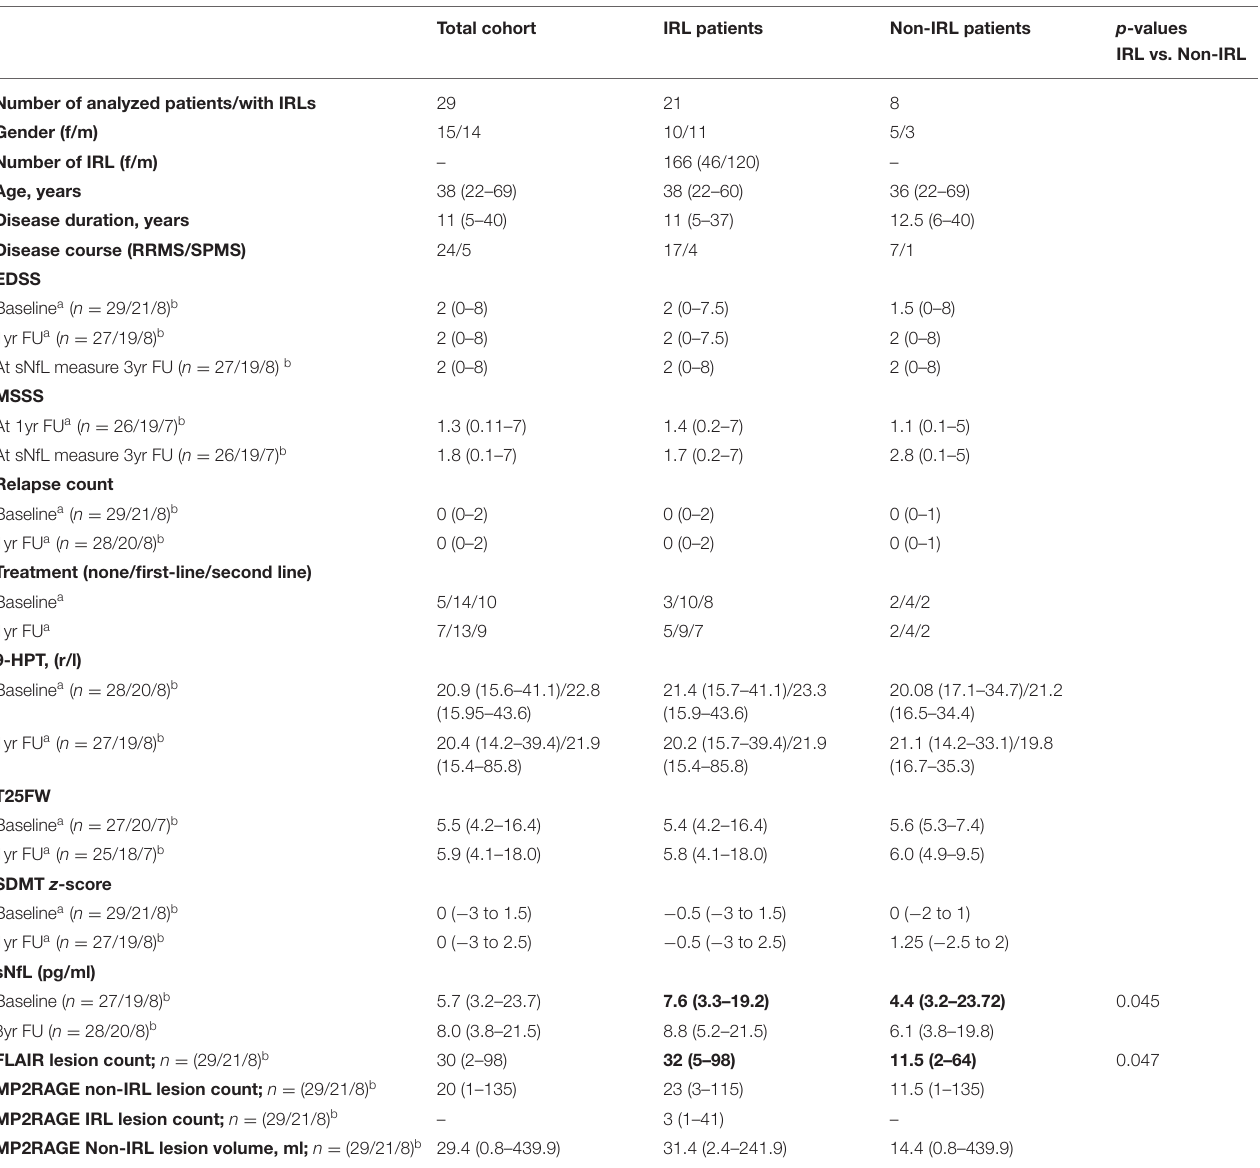
TABLE 1 | Demographic, clinical, and radiographic data of the total study cohort. Total cohort IRL